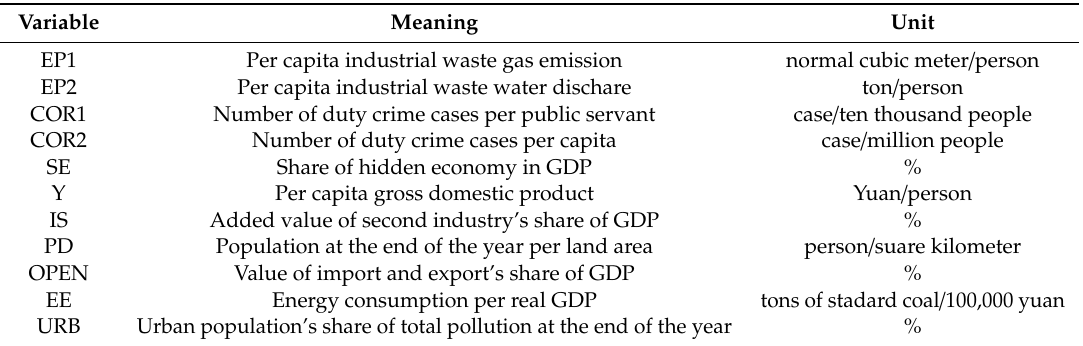
Table 2. Explanation of